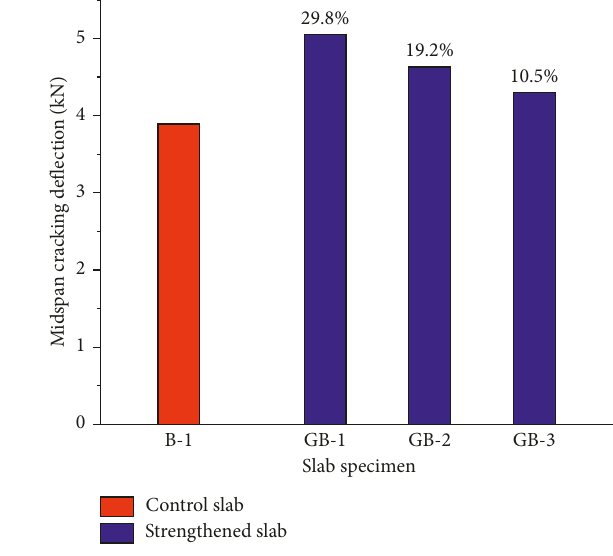
Figure 40: Midspan cracking